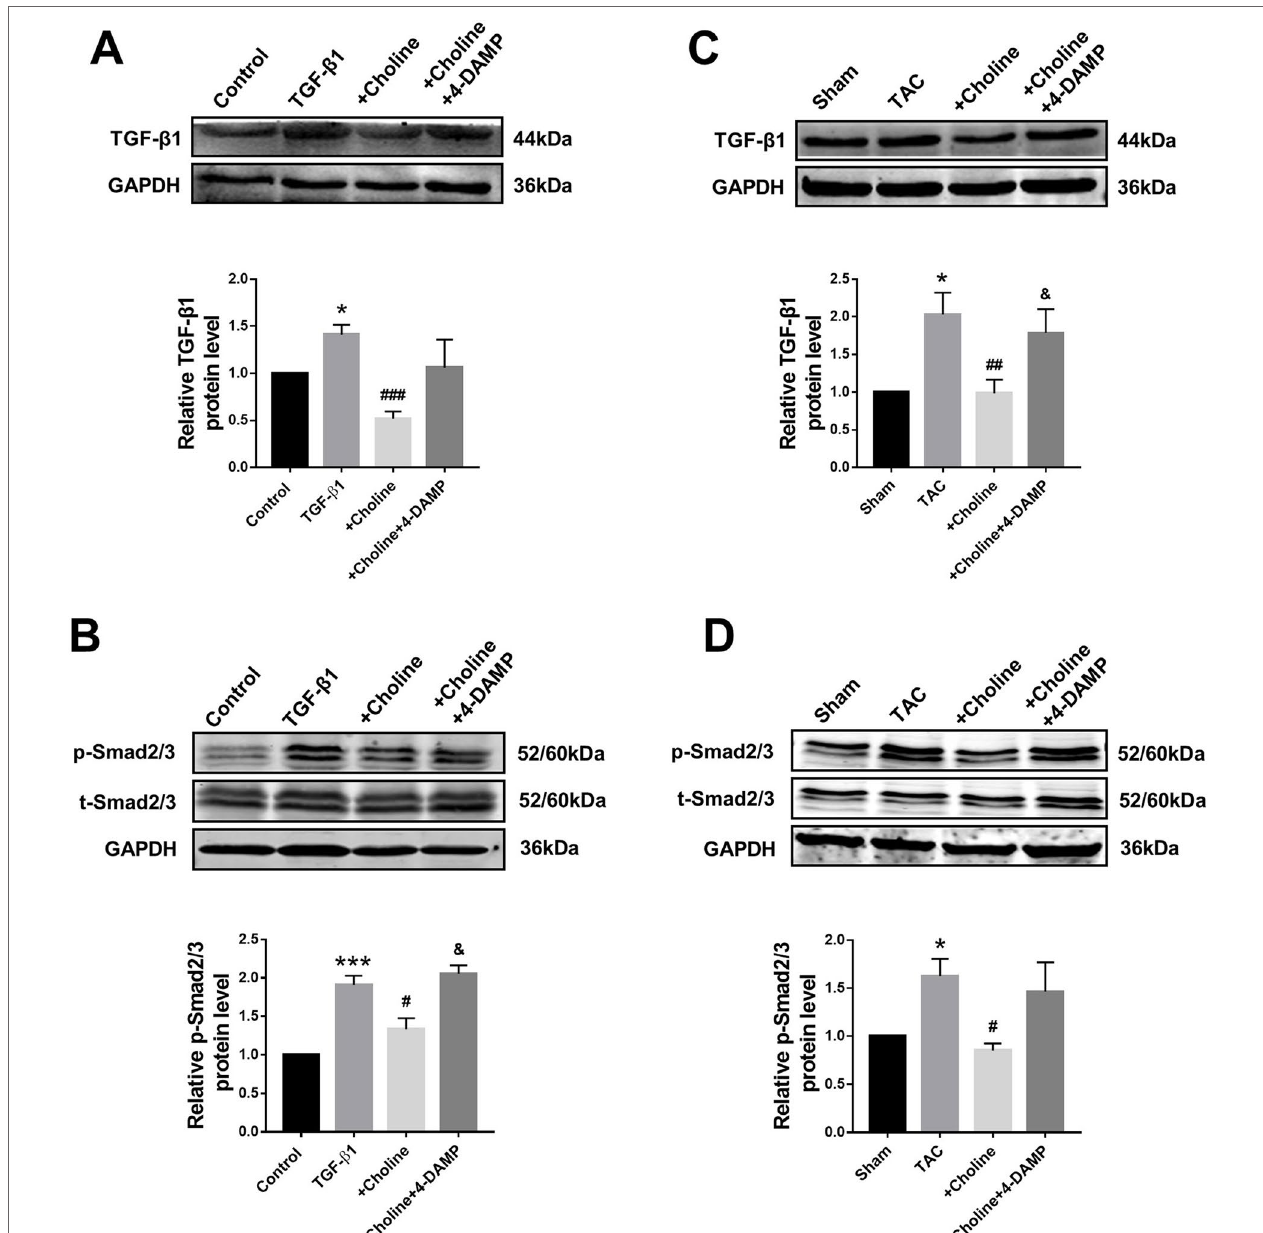
FIgURe 5 | Effects of choline and 4-diphenylacetoxy- N -methylpiperidine methiodide (4-DAMP) on protein levels of transforming growth factor beta 1 (TGF-β1)/ Smad2/3. (A) Effect of choline and 4-DAMP on TGF-β1 protein level in TGF-β1-induced cardiac fibroblasts (CF). * p < 0.01 vs. Ctrl, ### p < 0.001 vs. TGF-β1, n = 5. (B) Effect of choline and 4-DAMP on p-Smad2/3 protein level in TGF-β1-induced CF. *** p < 0.001 vs. Ctrl, # p < 0.05 vs. TGF-β1, & p < 0.05 vs. choline, n = 6. (C) Effects of choline and 4-DAMP on the protein level of TGF-β1 in transverse aortic constriction (TAC) mice hearts. * p < 0.05 vs. sham, ## p < 0.01 vs. TAC, & p < 0.05 vs. choline, n = 6. (D) Effects of choline and 4-DAMP on the protein level of p-smad2/3 in TAC mice hearts. * p < 0.5 vs. sham, # p < 0.05 vs. TAC, n =